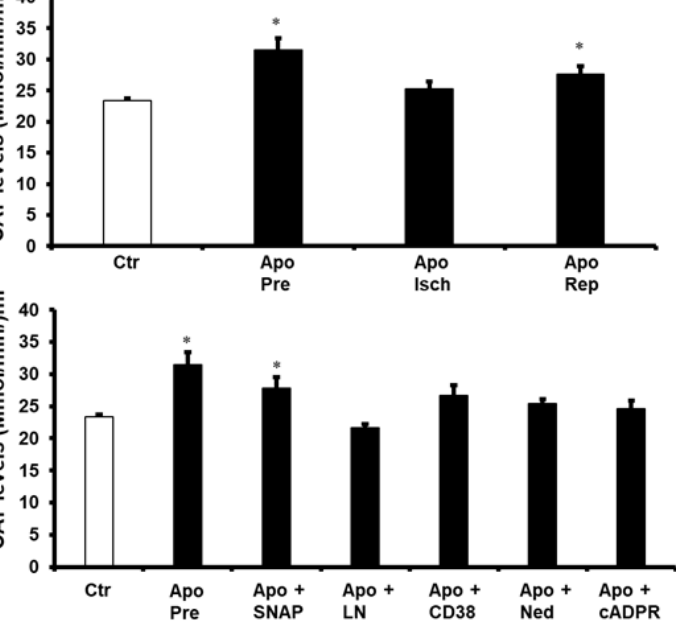
Figure 7. The levels of the antioxidant CAT in heart homogenates in all experiments. Quantification of SOD in hearts treated with apocynin or a combination of apocynin and SNAP, L-NAME, 78c, Ned, or cADPR agonist (n = 4 per group). Data are shown as means ± SEM. Ctr, control; Apo, apocynin; Pre, apocynin before ischemia; Isch, apocynin during ischemia; Rep, apocynin at reperfusion; SNAP, nitric oxide donor, LN, L-NAME; 78c, CD38 blocker; Ned, NAADP inhibitor; cADPR, cADPR agonist. * p < 0.05 compared to controls.